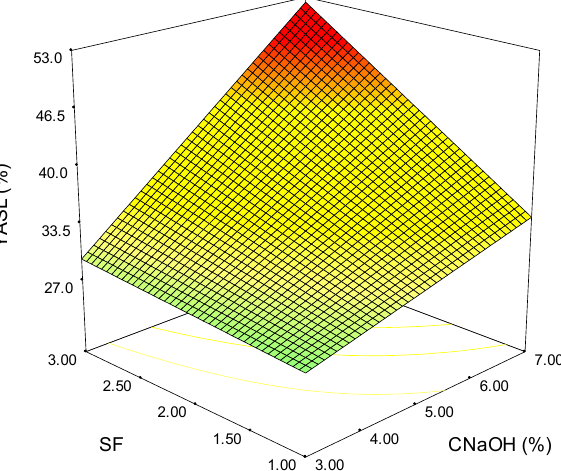
Figure 5. Variation of the acid-soluble lignin removal yield as a function of severity factor and alkali concentration (the colours green-yellow-red indicate the shift from low to high values).